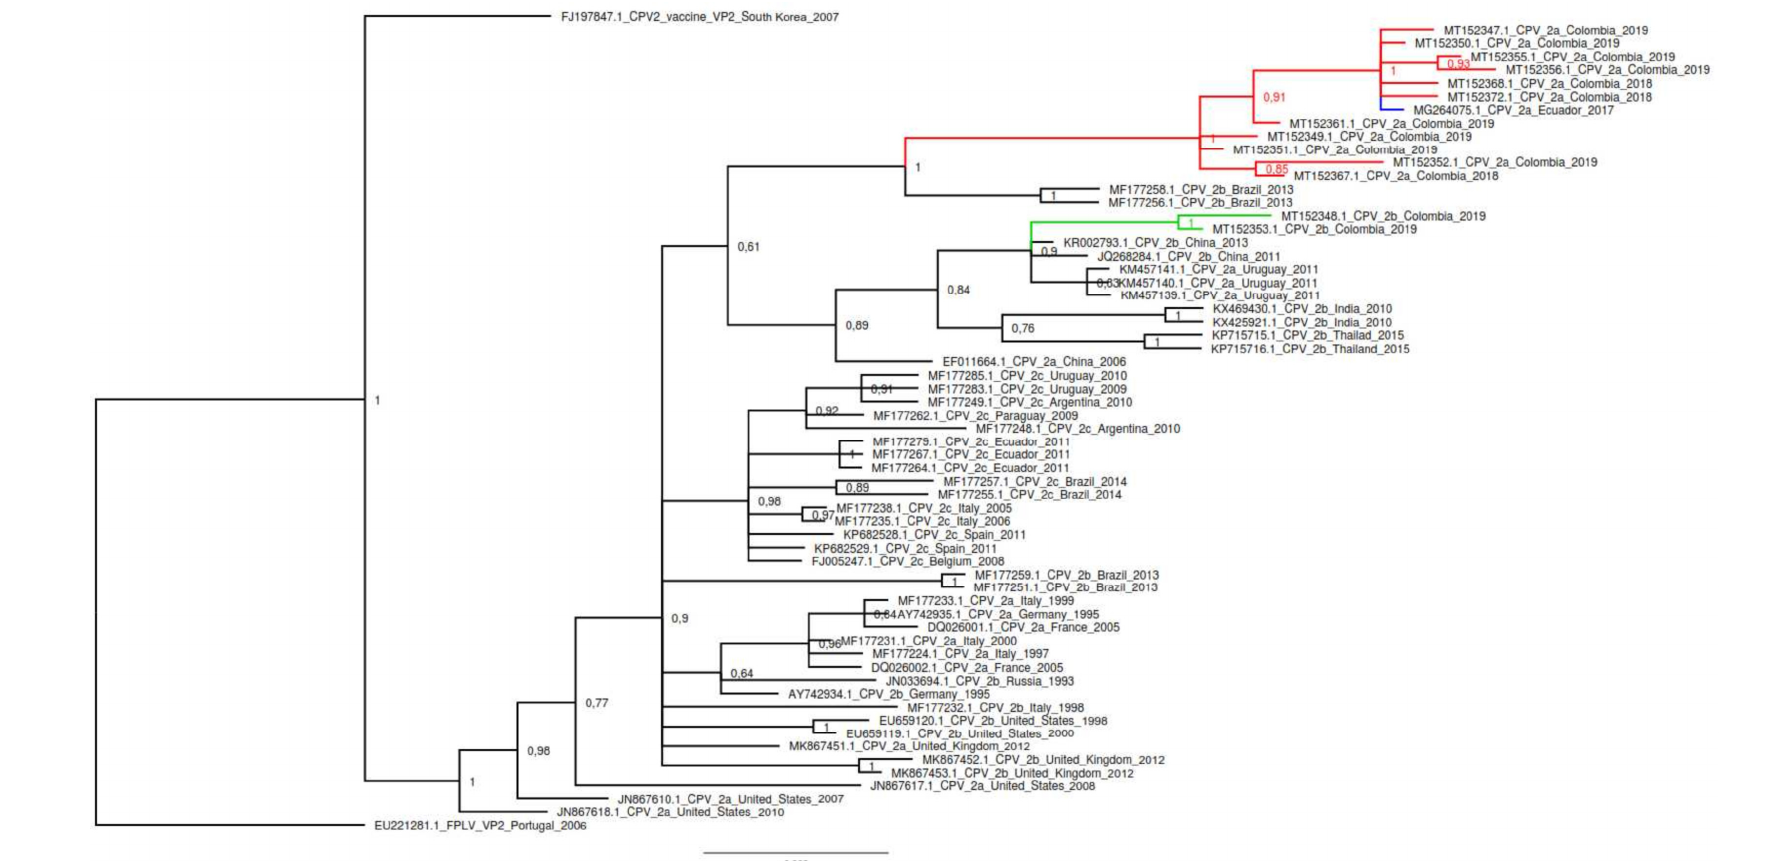
Figure 2. Phylogenetic Bayesian analysis of CPV-2 sequences. The phylogenetic analysis was performed using the nucleotide sequences of VP2 of the Colombian CPV-2a and CPV 2b variants and other sequences belonging to the three antigenic CPV-2a, CPV-2b and CPV-2c variants from different countries, as well as feline panleukopenia virus (FPLV) and original CPV-2 variants. The sequences are identified with the accession number, country, and date of collection. Tree was constructed with Bayes and every clade was supported by Bayesian posterior probabilities (BPP). The tree was rooted with the sequence of FPLV (EU221281.1). Red lines indicate the sequences belonging to the Colombian CPV-2a variant and the blue line indicates that belonging to the Ecuadorian CPV-2a variant related to Colombian samples. Green lines indicate the Colombian CPV-2b variant.